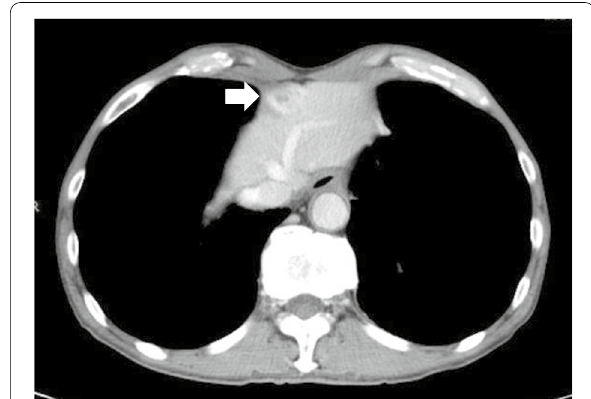
Fig. 1 Contrast-enhanced computed tomography of the falciform ligament abscess at the time of the first admission. A 25-mm, enhanced mass containing small low-density areas was observed below the center of the diaphragm (white arrow)